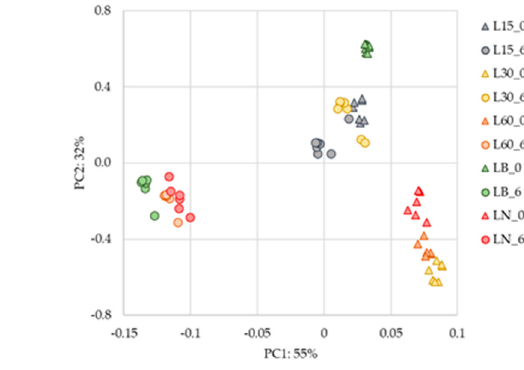
Figure 2. PCA representation of loadings and scores of all AWS samples and all volatile phenols analysed. Legend: C and L stand for the wood used in the ageing process, Chestnut and Limousin respectively; O15, 30 and 60 are the different micro-oxygenation modalities used in the alternative